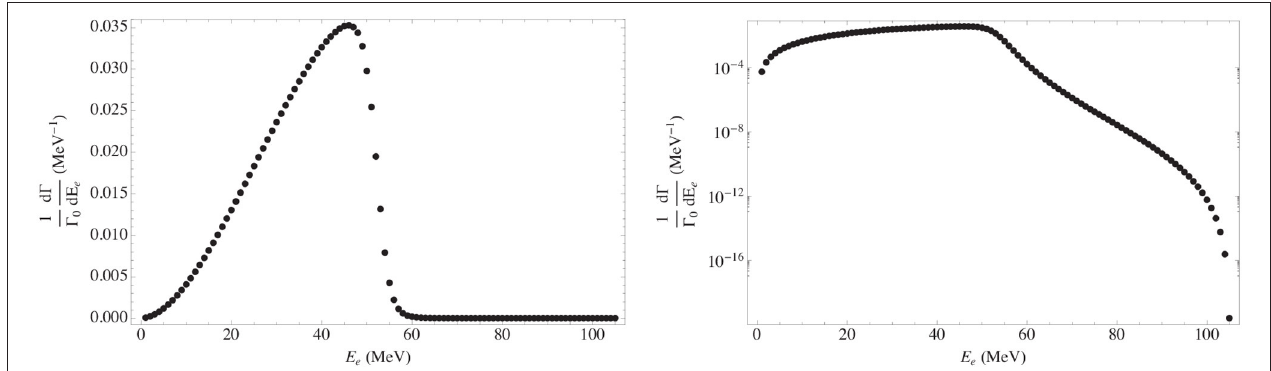
FIGURE 1 | Decay-in-orbit electron spectrum in aluminum near the endpoint, normalized to the free-muon decay rate Ŵ o . The Figure is taken from Czarnecki et al. [9]. The left-hand plot is on a linear scale, the right a logarithmic one.